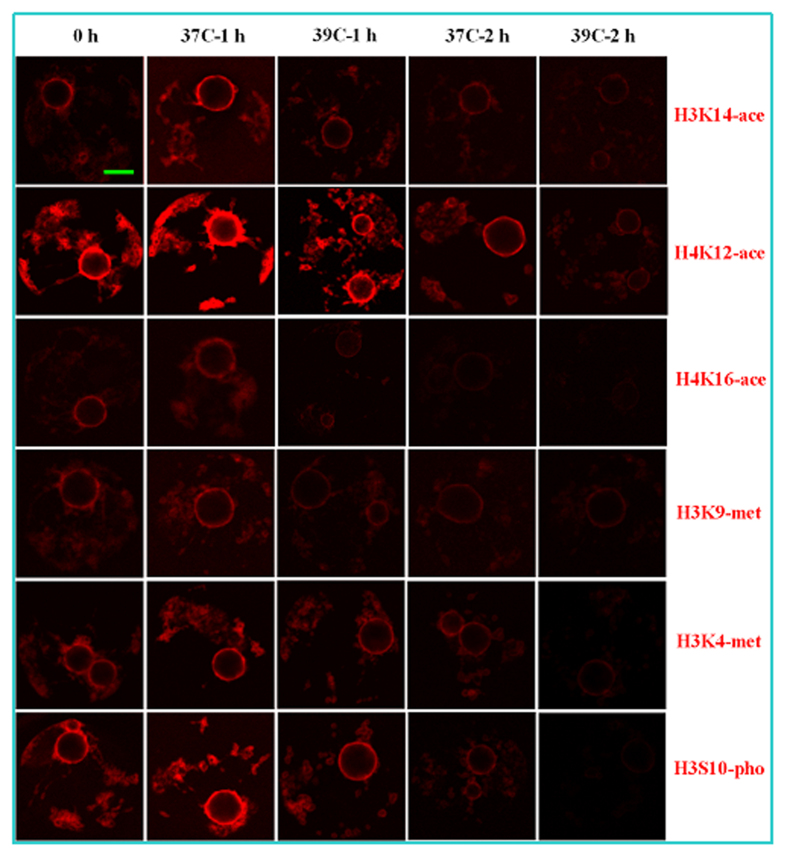
Laser confocal photomicrographs show acetylation (ace) of histone H3K14, H4K12 and H4K16, dimethylation (met) of H3K9 and H3K4, and phosphorylation (pho) of H3S10 in the SN oocytes before or after OH of prepubertal mouse ovaries at different temperatures for different times.Acetylated, dimethylated or phosphorylated histone was pseudo-colored red. Original magnification ×200. Scale bar is 10 μm.